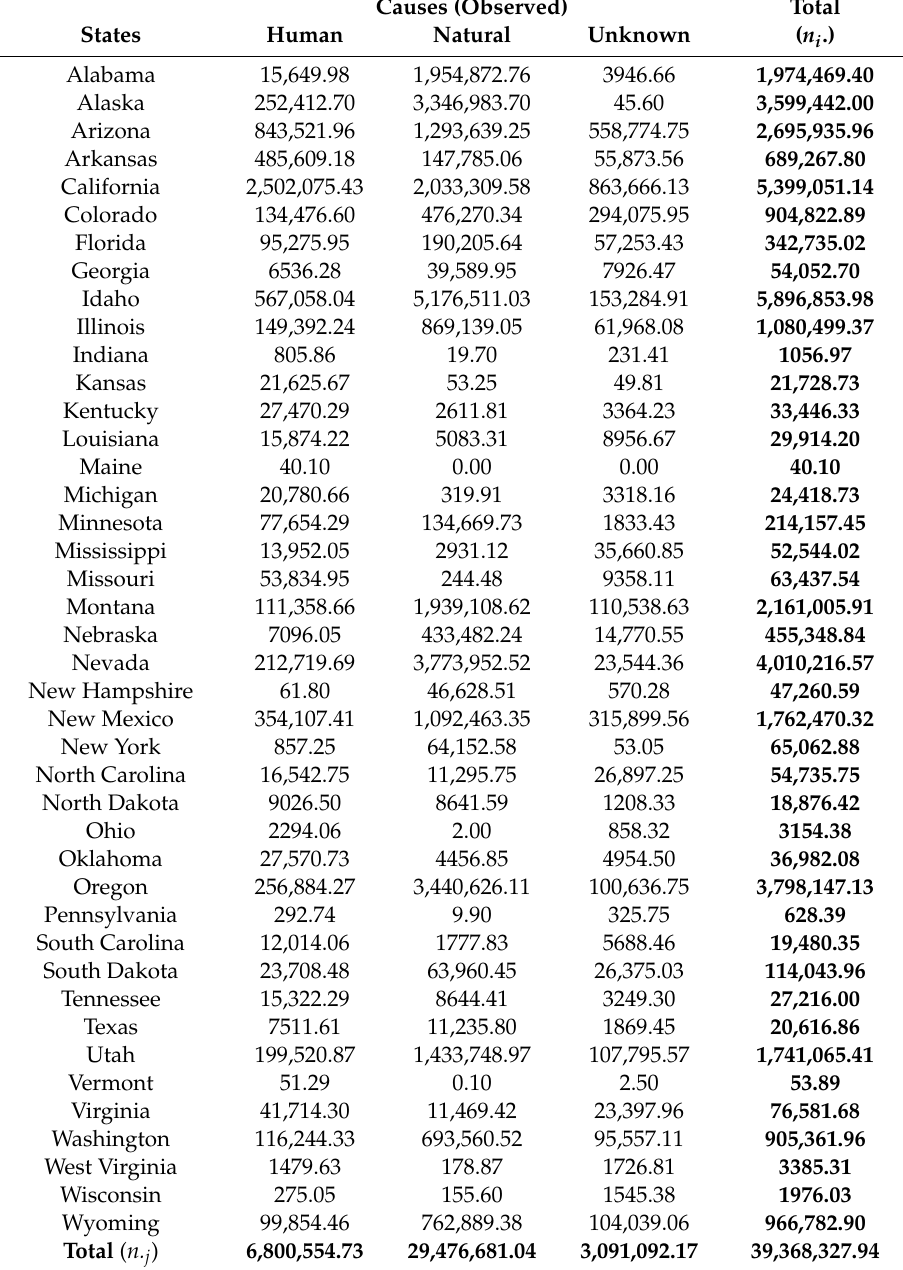
Table 4. Observed frequencies for fire causes and states (number of burned acres). Source: Own elaboration with data from BLM and